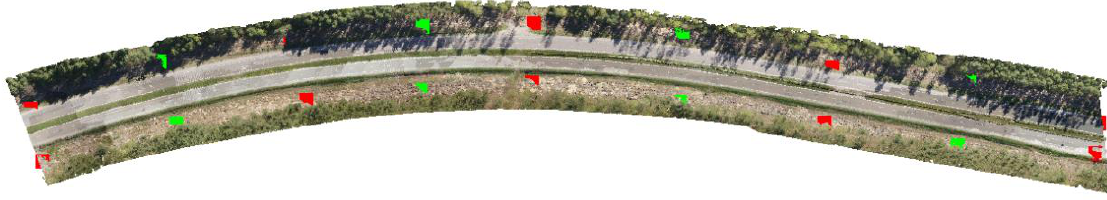
Figure 10. The curved highway with four segments and irregular GCP distribution.